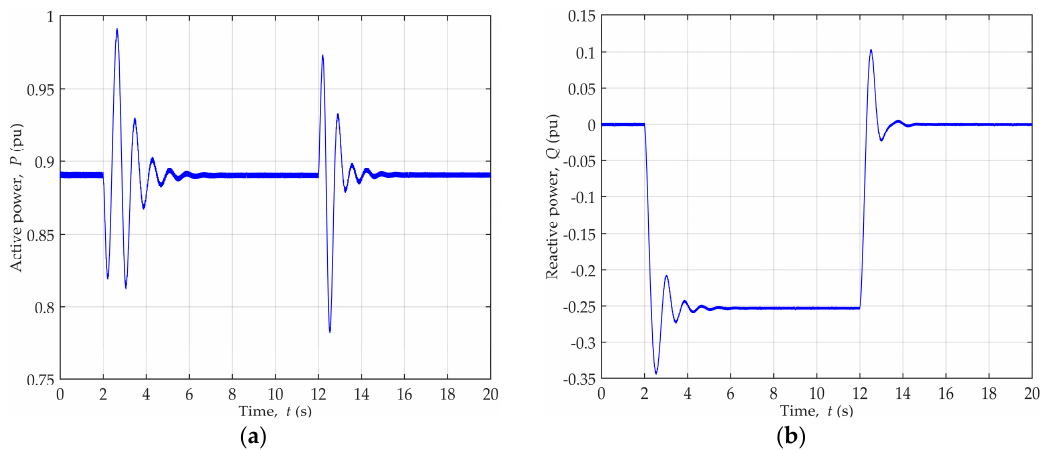
Figure 8. Generator power change during dynamic disturbances of reactive power for generator operating point P = 0.89, Q = 0: ( a ) Active power; ( b ) Reactive power.